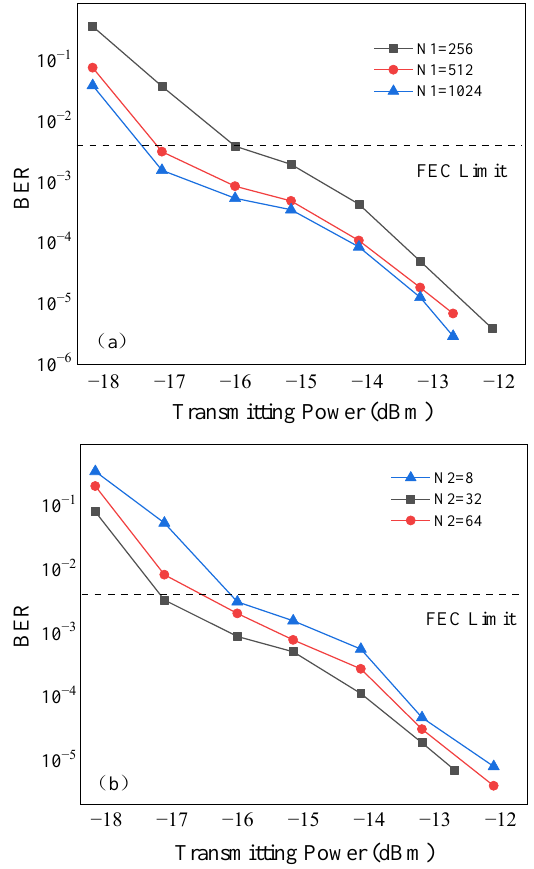
Figure 11. Experimentally measured BER as a function of transmitting power for different values of N1/N2.: ( a ) different N1 values, ( b ) different N1 values.